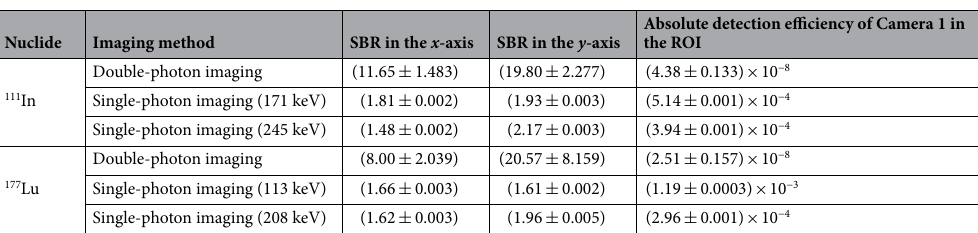
Table 2. Absolute detection efficiency for 3D imaging and SBR in the x - and y